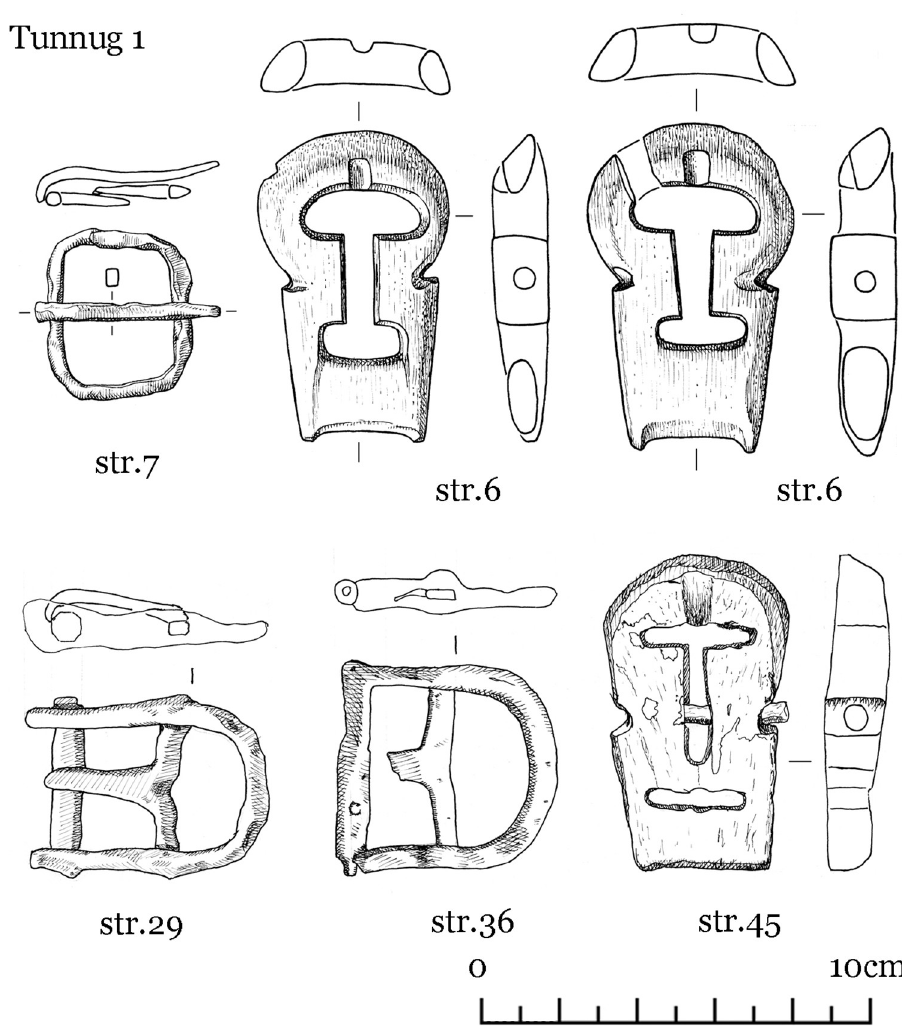
Fig 6. Tunnug 1. Medieval artifacts. Iron and bone